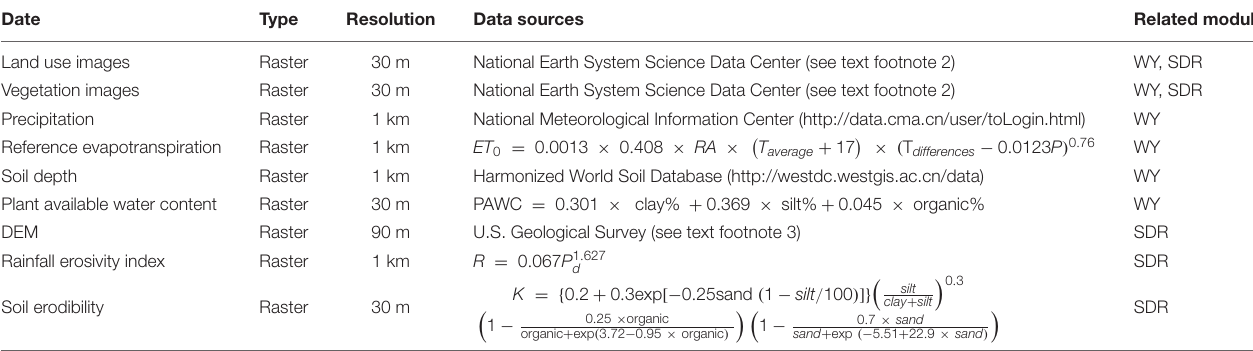
TABLE 1 | Data requirement for the integrated valuation of ecosystem services and trade-offs (InVEST) model (WY, Water Yield module; SDR, Sediment Delivery Ratio module).